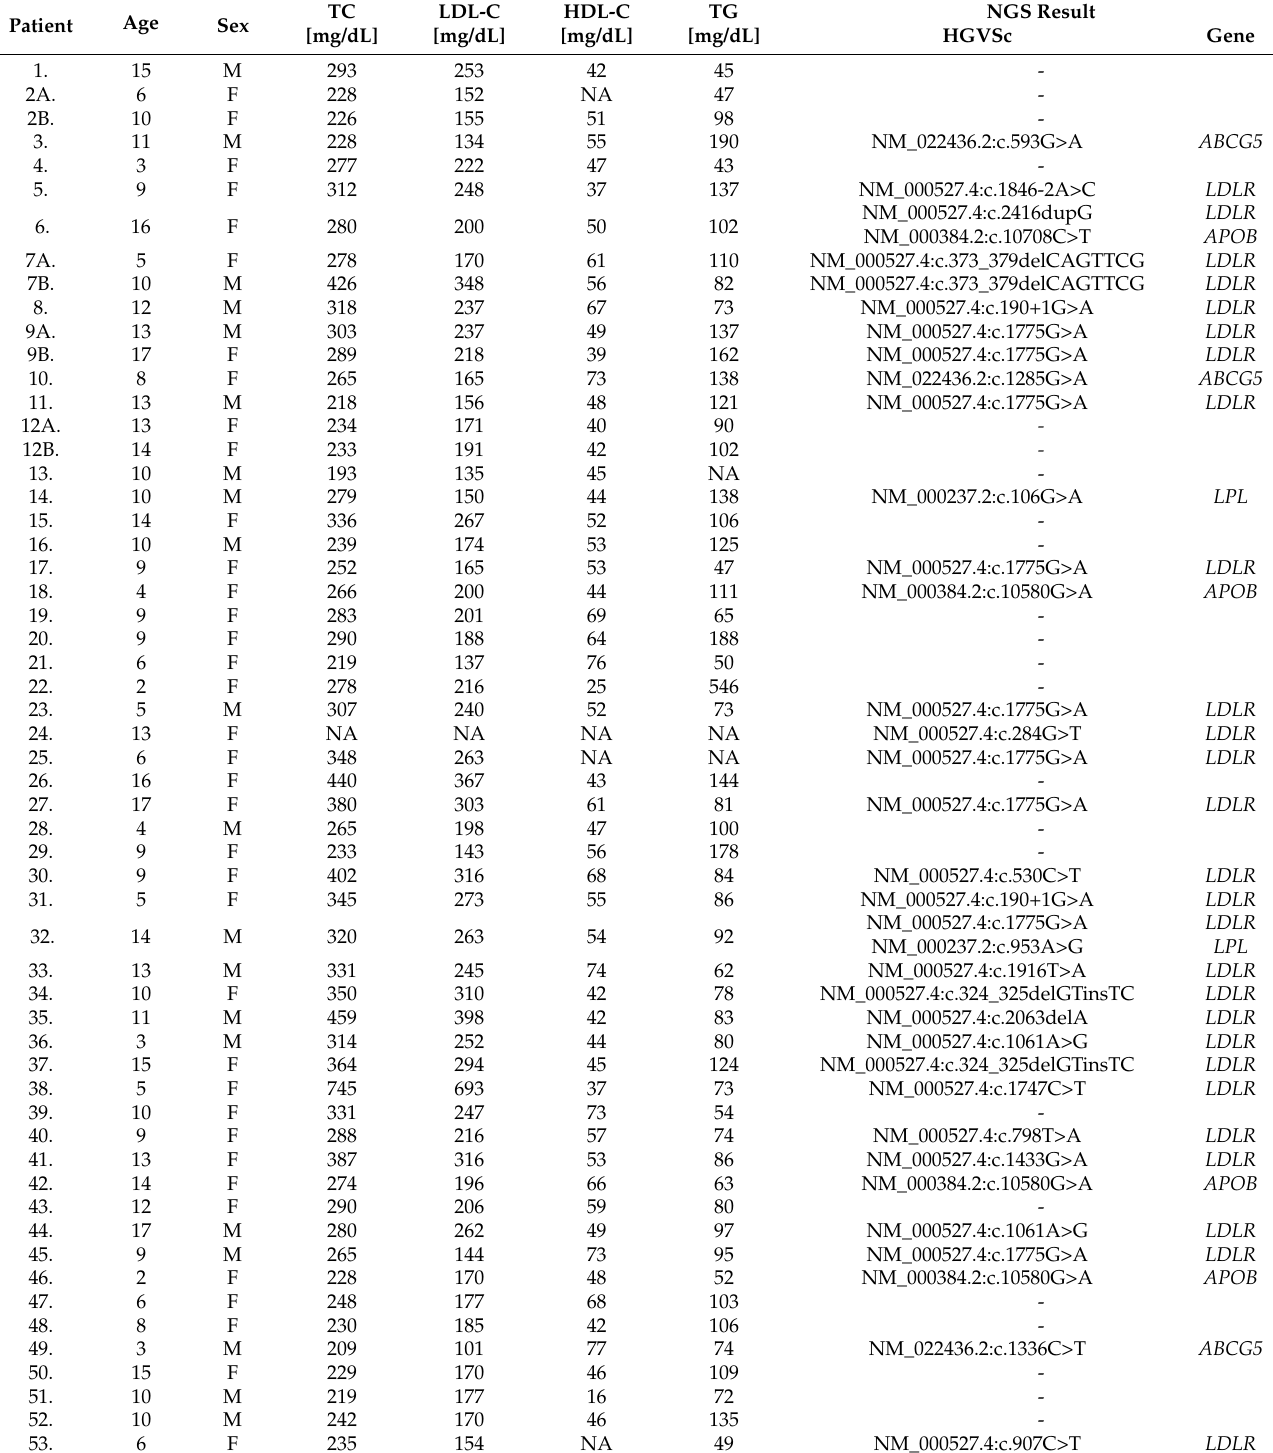
Table 1. Patient data and obtained genetic